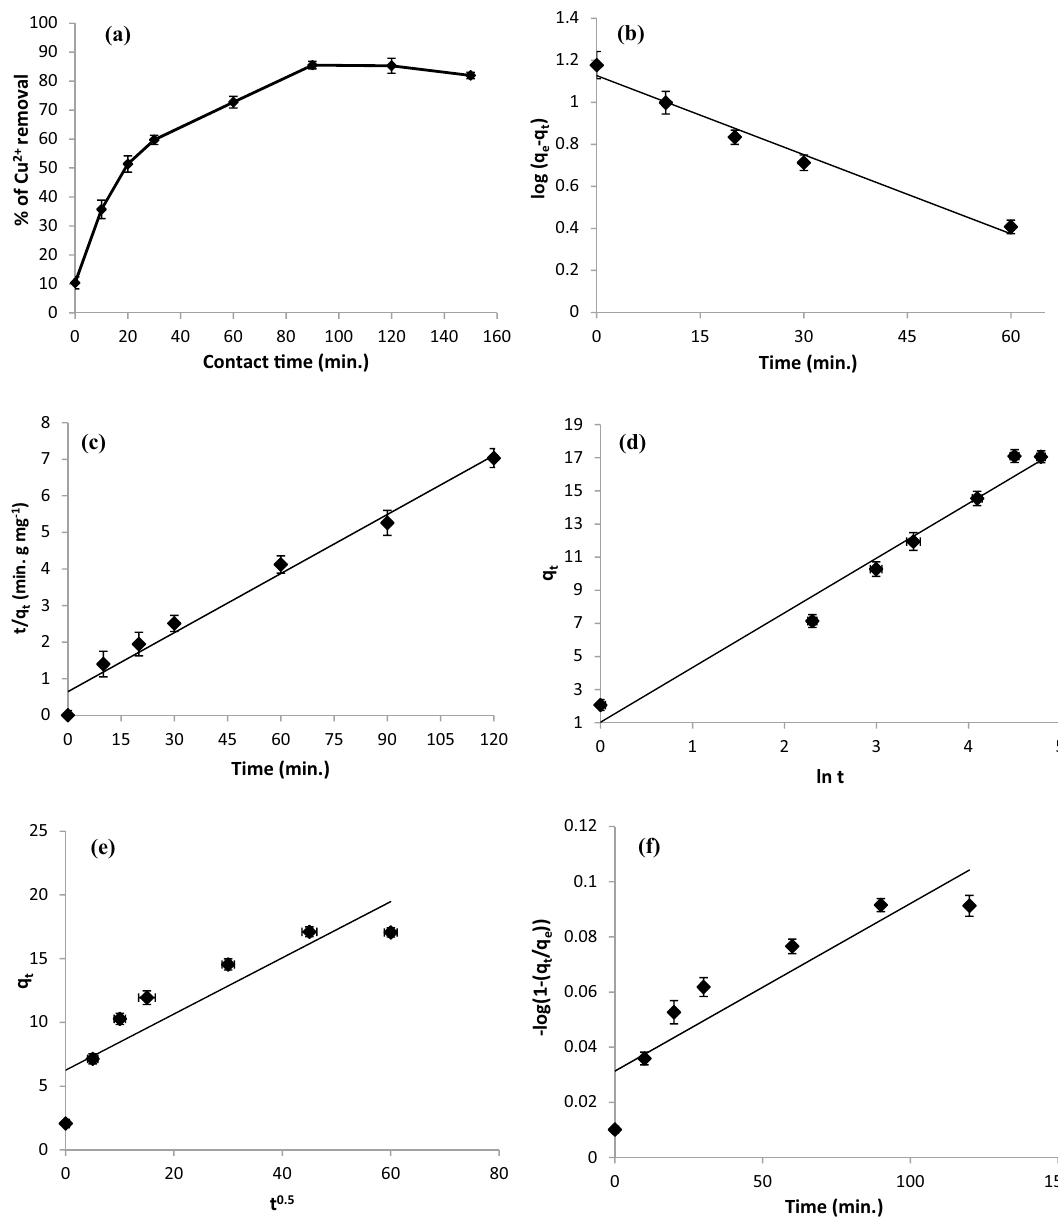
Figure 3. ( a ) Effect of contact time, ( b ) Pseudo-first-order plot, ( c ) Pseudo-second-order plot, ( d ) Elovich plot, ( e ) Intra-particle diffusion plot, and ( f ) film diffusion plot for the biosorption of Cu 2+ ions onto R. damascena leaves. Data is presented as average ± SE of three